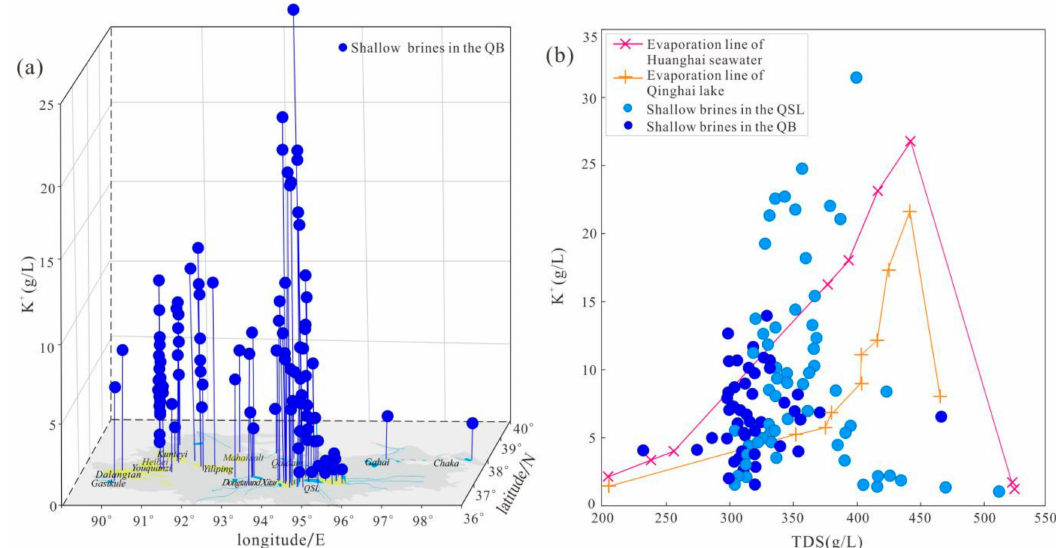
Figure 8. The shallow K-rich brines in the QB: ( a ) The K + concentrations and distribution of the shallow brines; ( b ) the relationship between K + concentrations and TDSs of the shallow brines.